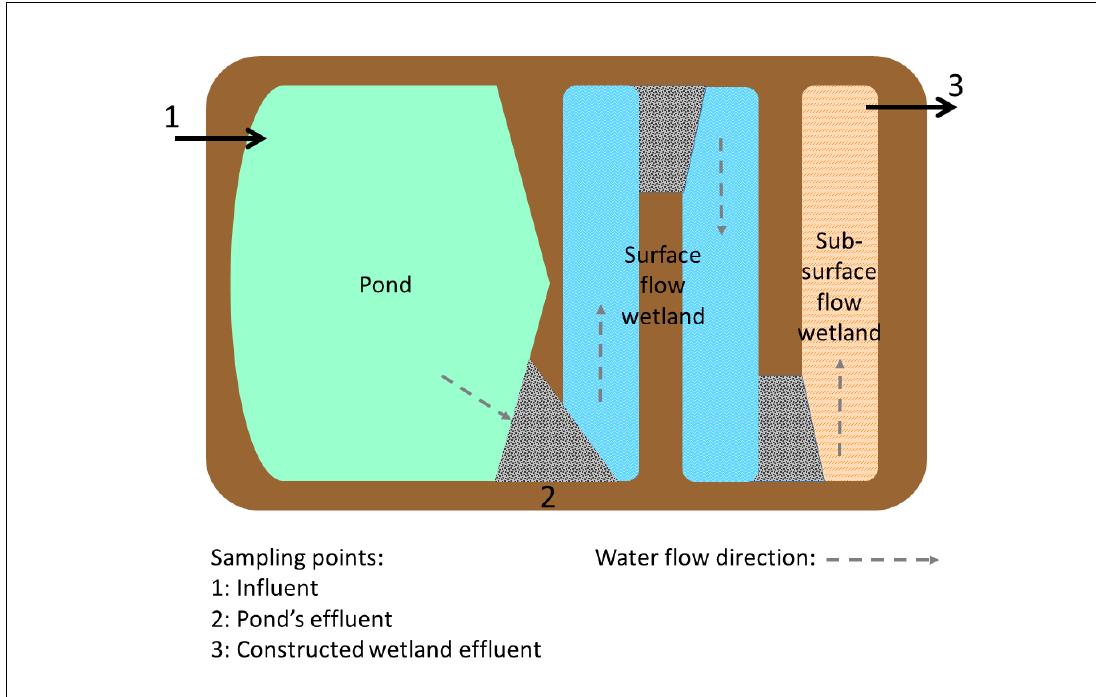
Figure 1. Layout of WWTP5 and sampling points.